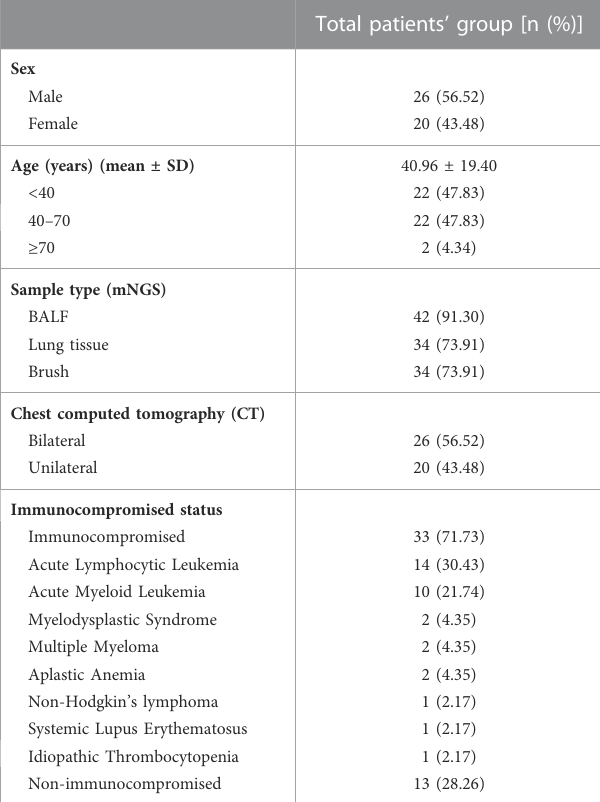
TABLE 1 Baseline characteristics of the patients (N = 46). Total patients ’ group [n